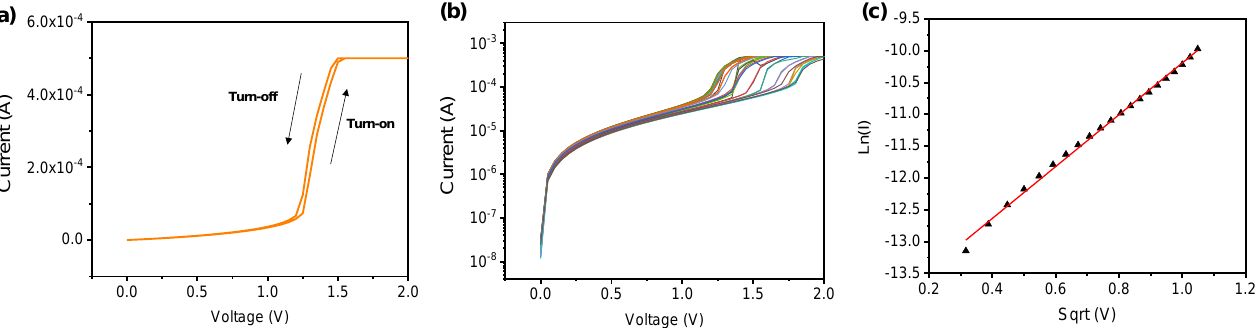
Figure 2. ( a ) Typical threshold switching and ( b ) repetitive curve of TiN/TaO x /ITO devices, ( c ) Fitting plot for ln( I ) versus sqrt ( V ) of threshold I–V curve.